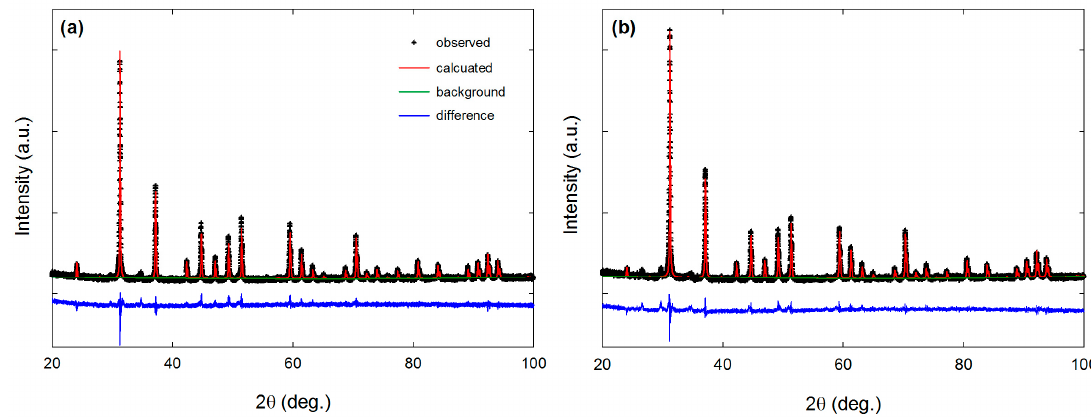
Figure 1. Powder X-ray diffraction (XRD) data for ( a ) Yb 0.13 In 0.02 Co 3 FeSb 12 and ( b ) Yb 0.39 In 0.02 Co 2.4 Fe 1.6 Sb 12 , including profile fit, profile difference, and profile residuals from Rietveld refinement. Table 1. Rietveld refinement results for Yb 0.13 In 0.02 Co 3 FeSb 12 and Yb 0.39 In 0.02 Co 2.4 Fe 1.6 Sb 12 . Nominal Composition